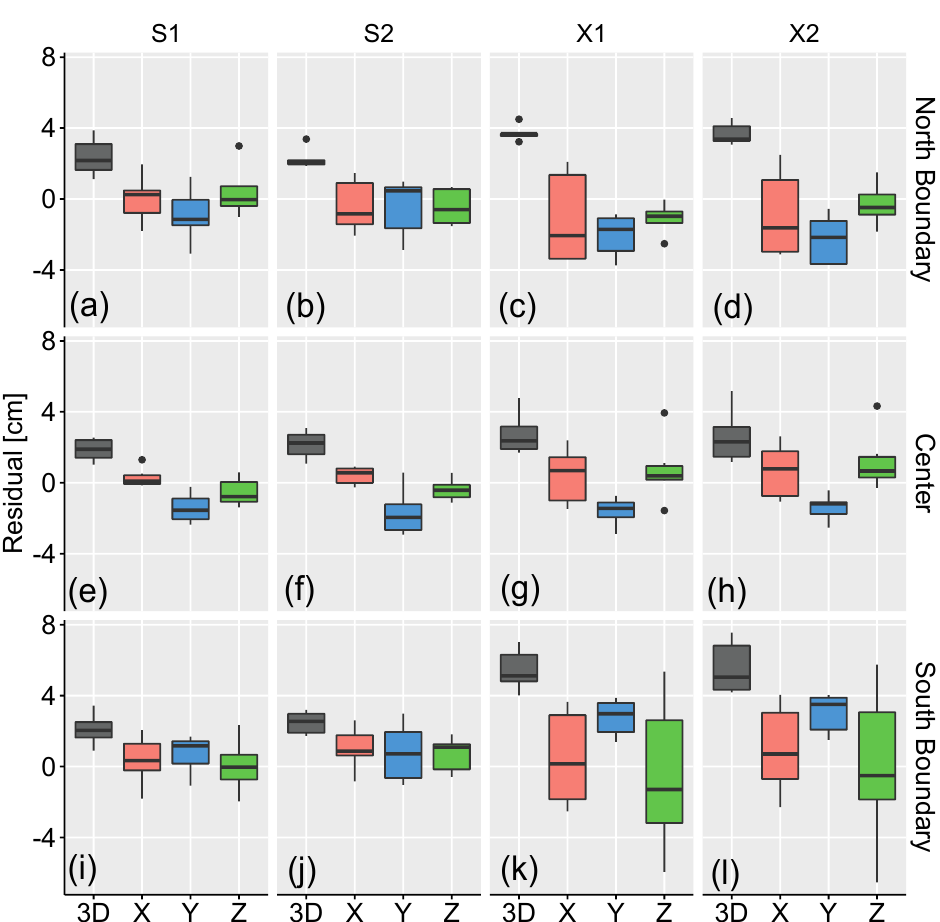
Figure 7. Comparison of CPs residuals for Palar study area. Statistics are computed diving the CPs according to their location (Figure 3b) into three areas: ( a – d ) North boundary (including check points P02, P06, P05, P09 and P18), ( e – h ) Center (P08, P10, P12, P16, P14 and P21) and ( i – l ) South boundary (P23, P24, P27, P29, P30 and P33). ‘S’ surveys were performed with the Sony camera, whereas ‘X’ refers to X5S datasets. The 3D total error is reported in gray, while pink, blue and green represents residuals in the X , Y and Z direction, respectively. These results were obtained using all available